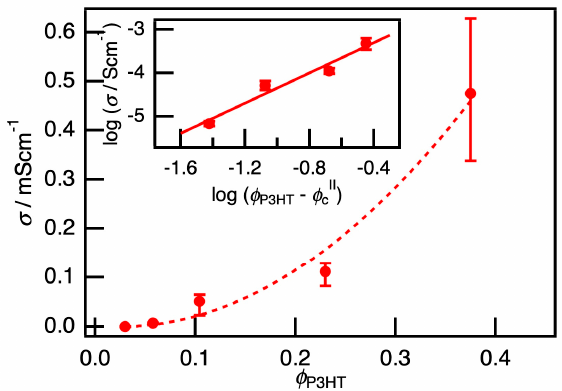
Figure 3. The volume fraction of P3HT nanofiber ϕ P3HT dependence of the conductivity σ . The